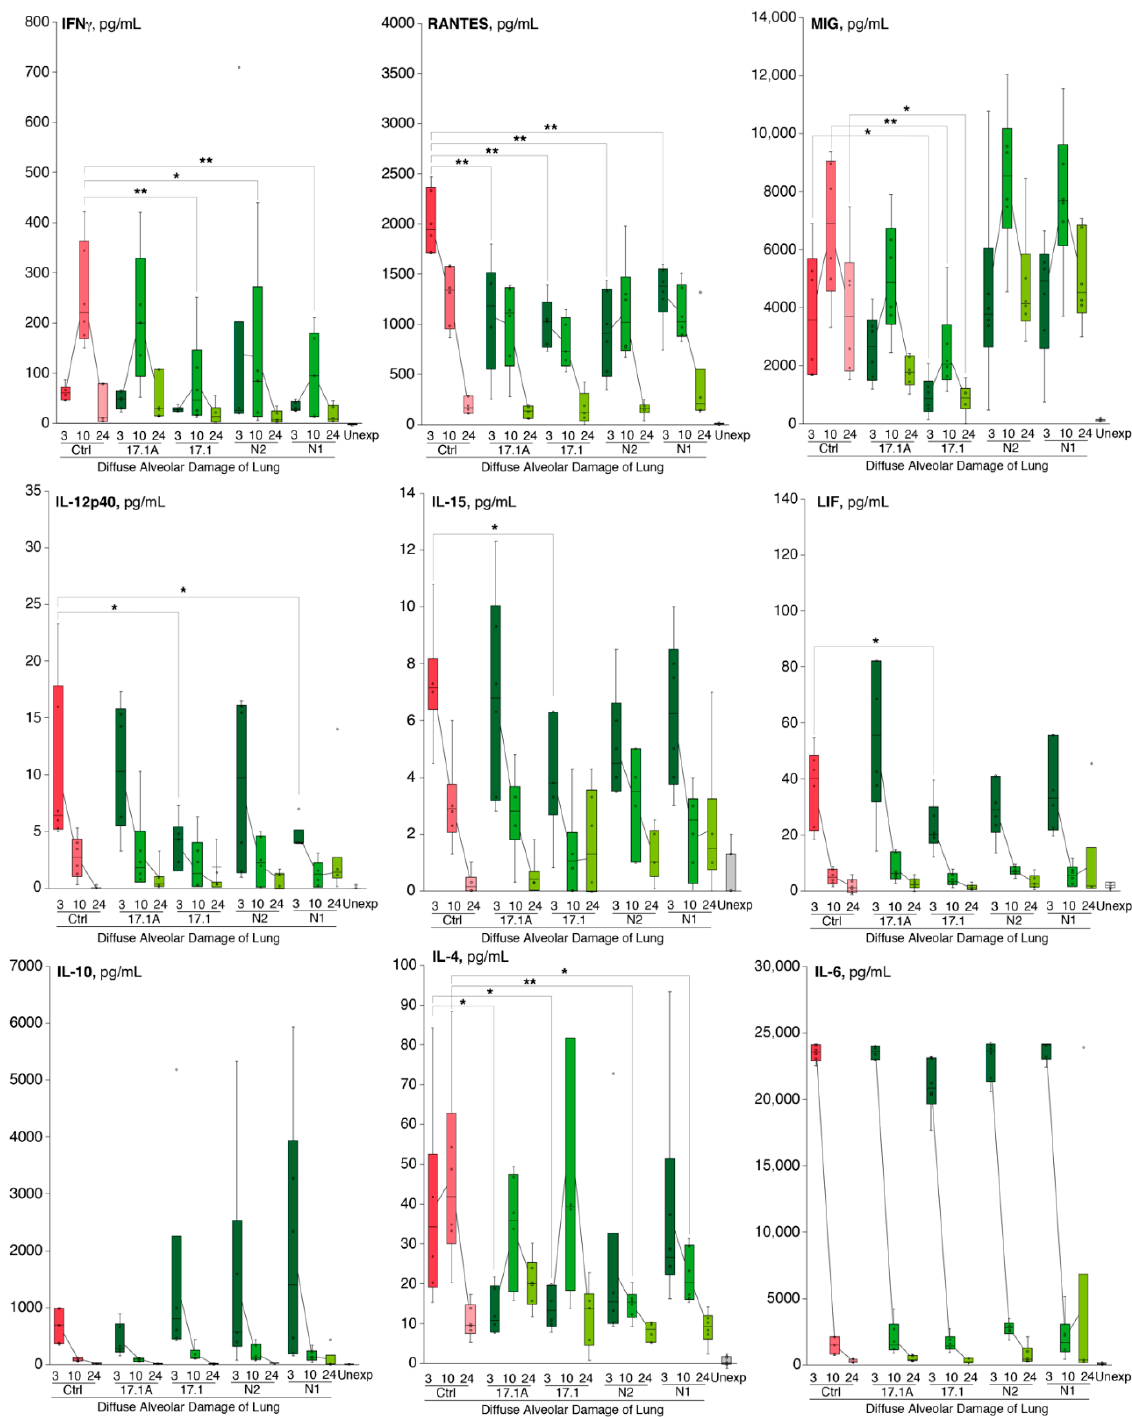
Figure 6. Administration of Tag7-derived peptides counteracts cytokine storm during diffuse alveolar damage of lung induction. Level of plasma cytokines in mice with DAD (red bars) after 3, 10 and 24 h after syndrome induction in comparison with unexposed animals (grey bars) and animals treated with Tag7 peptides (green bars). Bars represent median with interquartile range; 95% confidence interval is shown. Leukemia inhibitory factor (LIF); monokine induced by gamma (MIG/CXCL9); interferon-gamma (IFN γ ); regulated upon activation, normal T cell expressed and secreted (RANTES/CCL5). Asterisks indicate statistically significant differences between treated and untreated animals with DAD at respective timepoints. All animals with DAD have dramatically increased levels of analyzed cytokines and chemokines in comparison with unexposed animals regardless of treatment (one-way ANOVA, p -value: ** < 0.05, * <